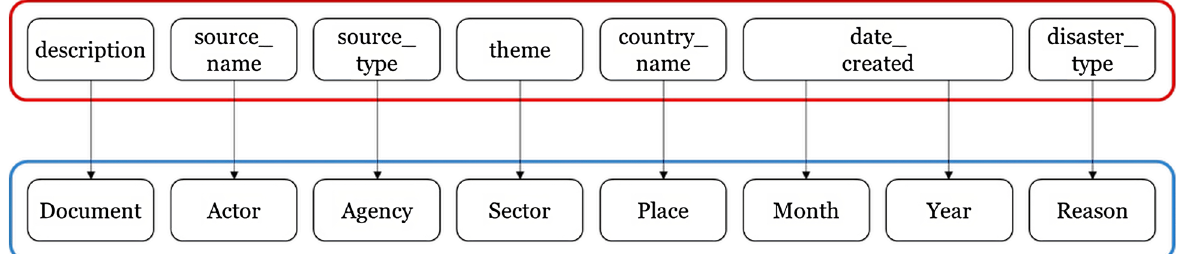
Fig. 1 Mapping original dataset structure to new dataset